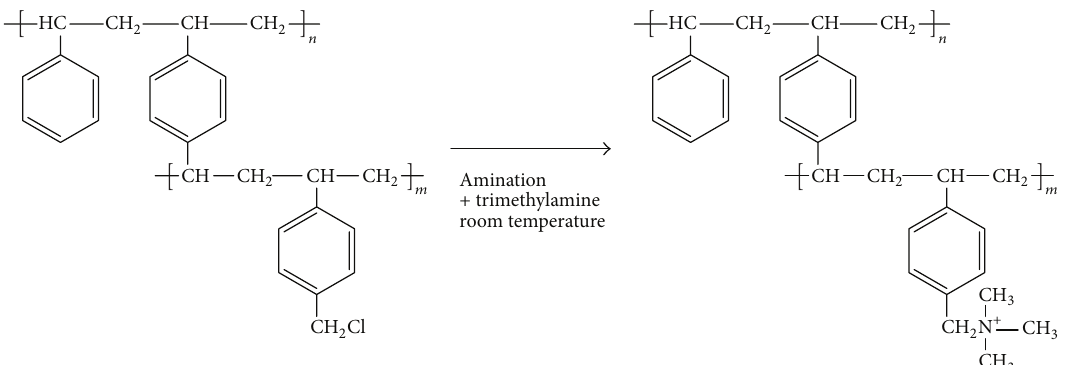
Figure 2: Amination of poly(styrene-co-divinylbenzene-co-4-vinylbenzylchloride) surface layer using